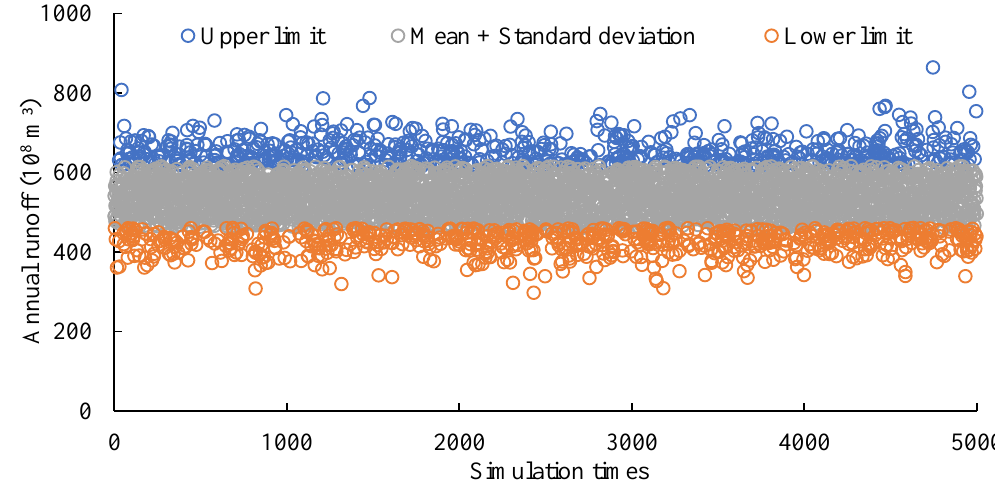
Figure 7. Simulated annual runoff of the NZD hydropower plant.